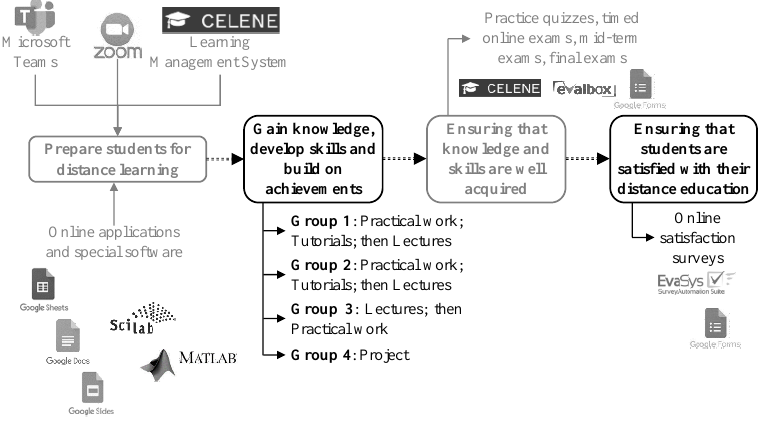
Fig. 1. The method of remote knowledge acquisition and